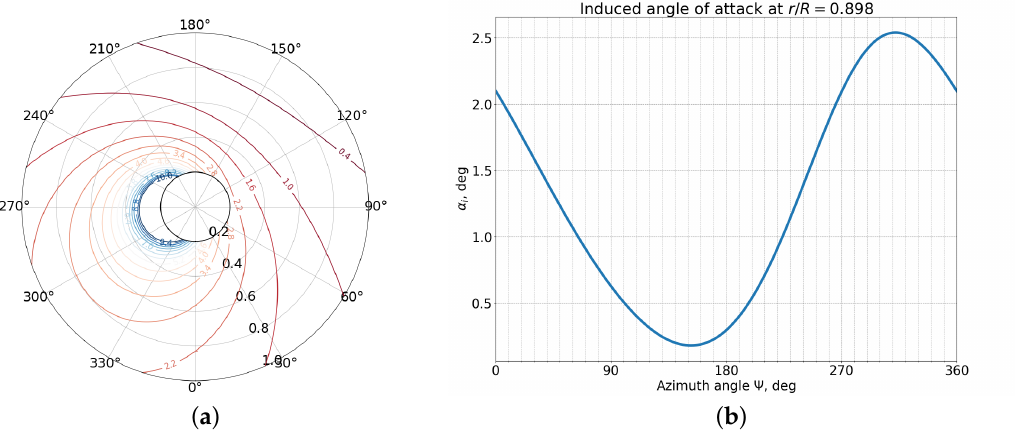
Figure 21. Induced AoA according to BEMT, α i = V i / U ( r , Ψ ) ; ( a ) rotor map of α i ; ( b ) α i at r / R =